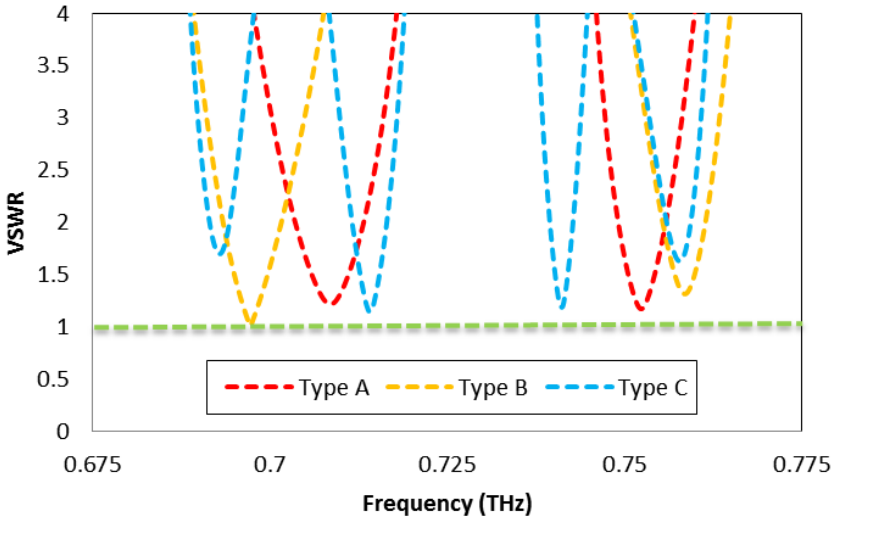
Figure 10. Comparison of all types of array antennas on the bases of